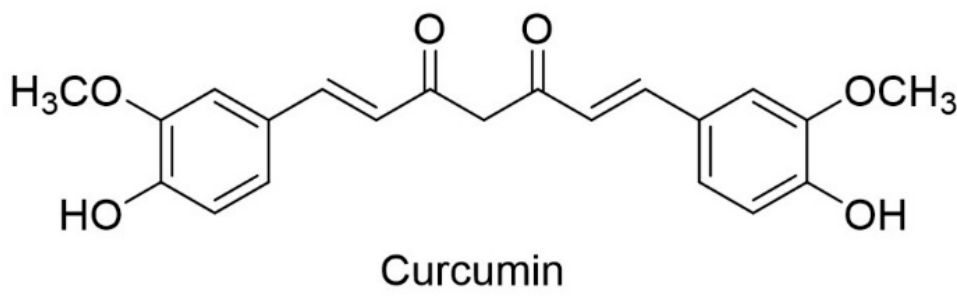
Figure 1. Structure of curcumin (ketone tautomer).